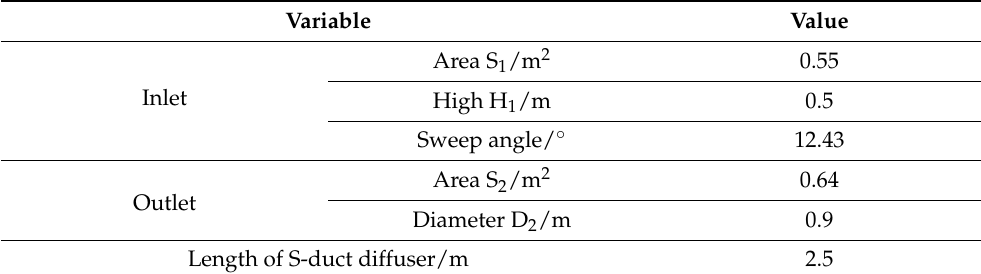
Figure 1. Model of S-duct intake. Table 1. Dimensions of inlet and outlet. Table 1. Dimensions of inlet and